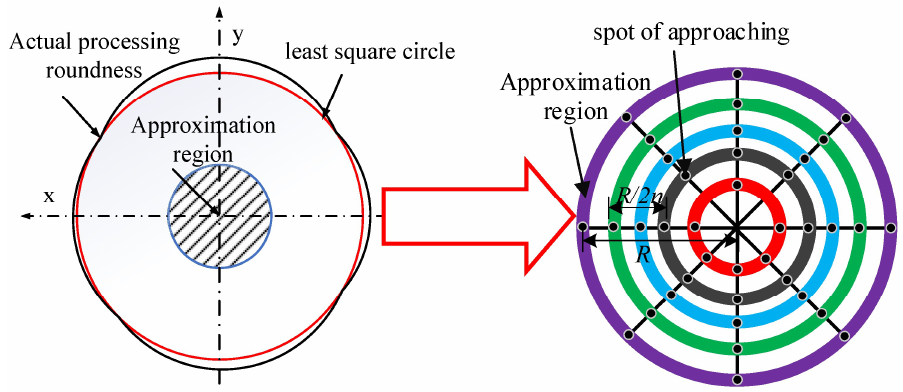
Figure 7. Schematic diagram of sphericity approximation method.